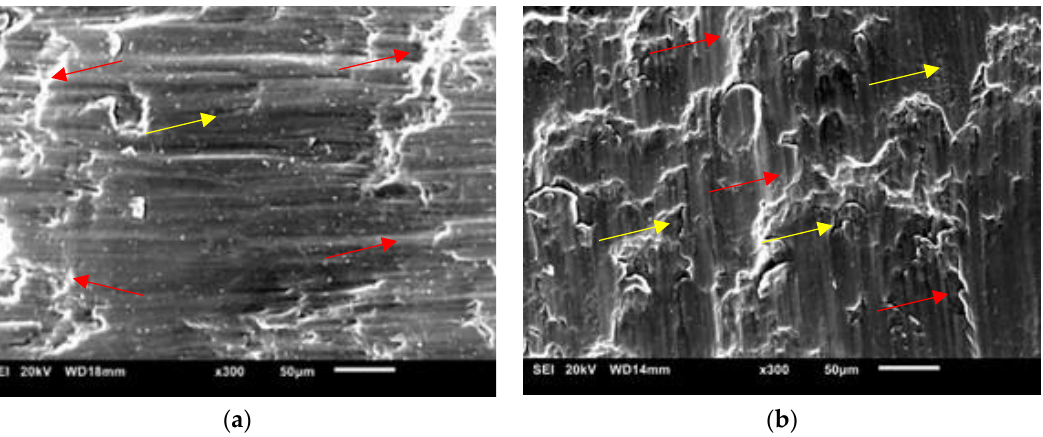
Figure 6. Fractographs of ( a ) as-extruded and ( b ) as-extruded + DCT Mg/2wt.%CeO 2 samples. The